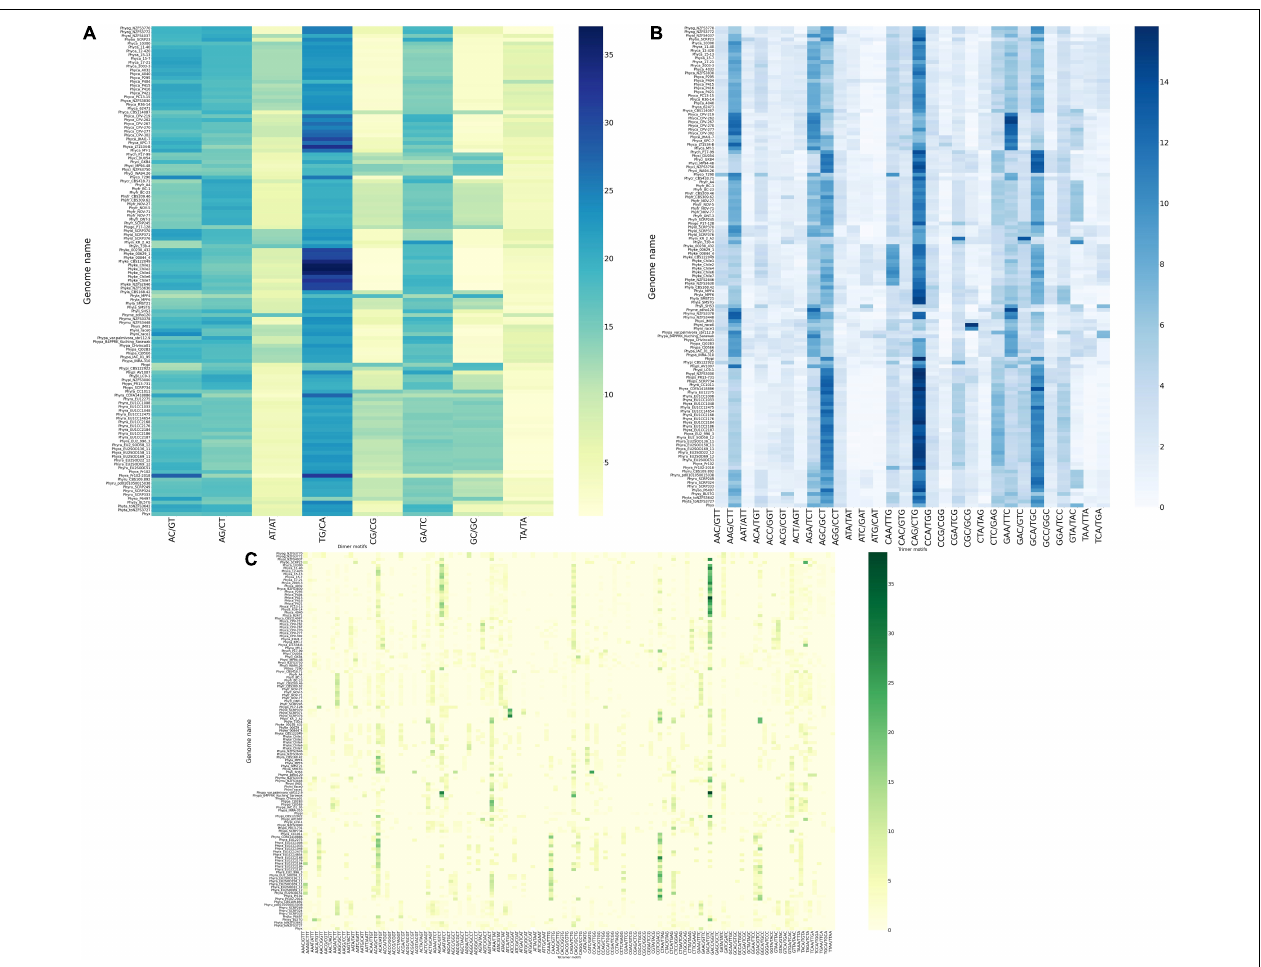
FIGURE 2 | Construction of heatmap of SSR motifs. (A) Heatmap of dinucleotide motifs. Out of eight group motifs, TG/CA motif was the most preferred motif in all the genomes and P. kernoviae contains the highest percentage of motifs among all the Phytophthora genus. Scarcity of AT- containing motif is clearly visible. (B) Heatmap of trinucleotide motifs. CAG/CTG motif preference is found in maximum number of genomes. Only a few trinucleotide motifs are predominant, while clearly, the AT-containing motifs such as ATG/CAT and ATC/GAT are very scarce. (C) Heatmap of tetranucleotide motifs. There is a clear dominance of GACA/TGTC- containing motif, which has a TG/CA pattern embedded in it.